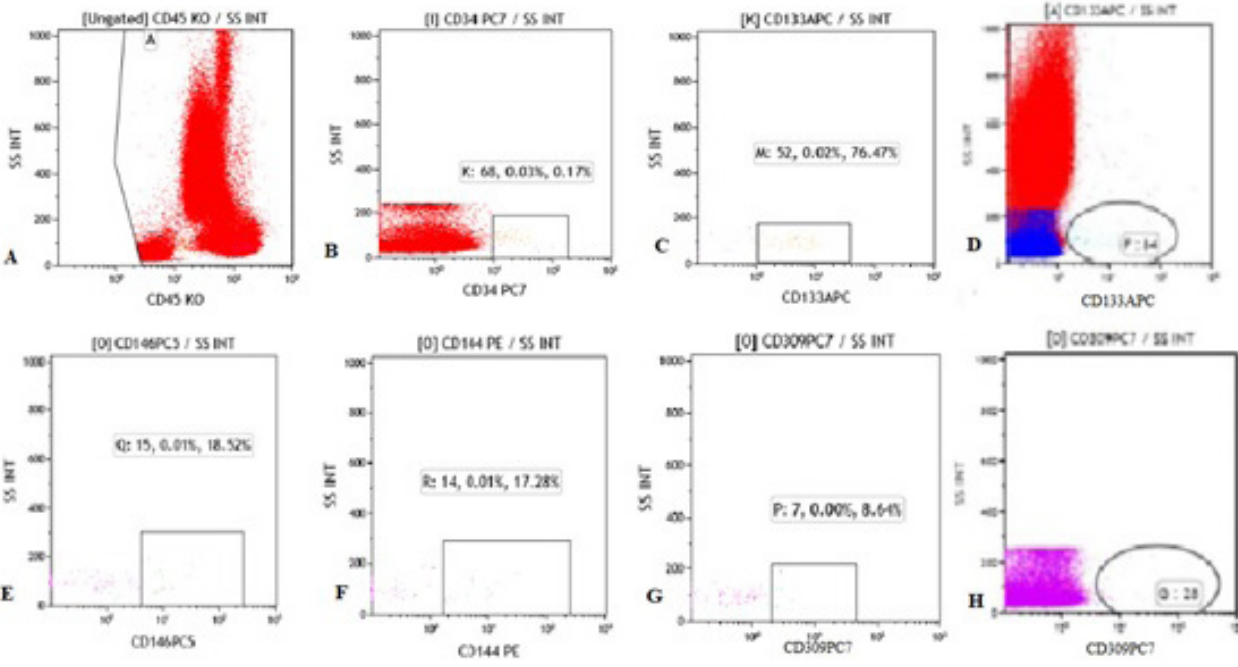
Fig. 1 - Representation of flow cytometry gating models of endothelial progenitor cell (EPC) markers at the control sample (C1). Cells were labeled with fluorescent marker antibodies targeting the hematopoietic progenitor, endothelium, leukocyte, and monocyte cell. According to expression levels of antibodies, EPCs were gated and evaluated, and the number of EPCs was calculated on both total cell count and % gated values in flow cytometry